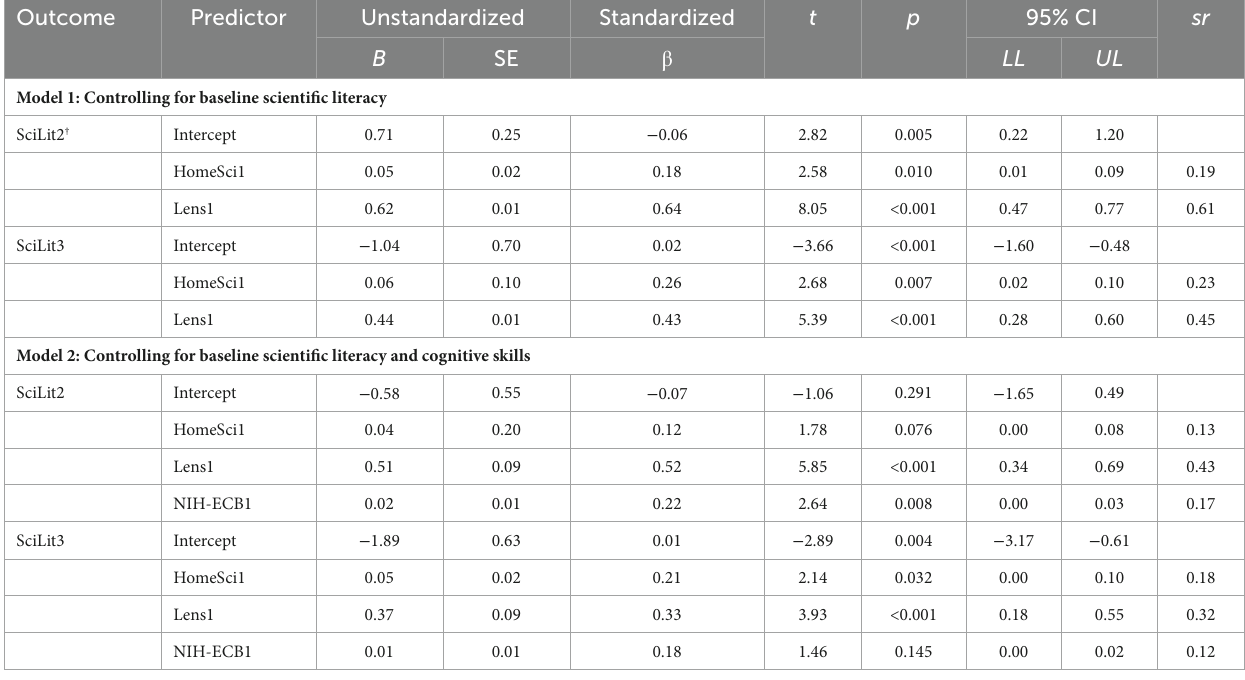
TABLE 8 Multivariate regression analyses for home science environment at Wave 1 predicting scientific literacy at Wave 2 and 3.